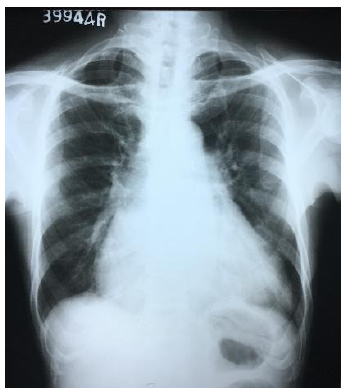
Figure 1 - CXR showing a dilated